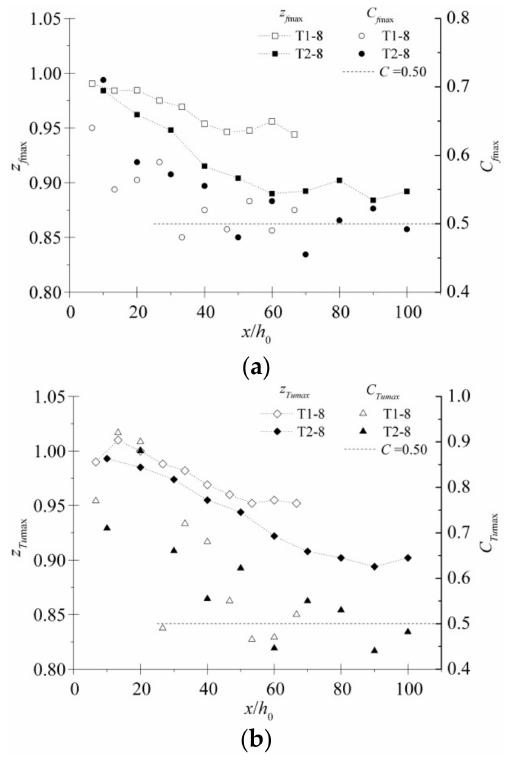
Figure 7. Variation of maximum bubble frequency and turbulence intensity positions along the developing and developed